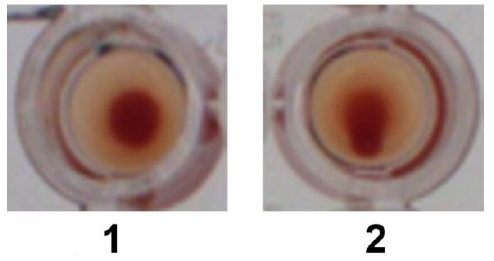
Figure 1. Sample images of wells in which HA occurred (1; no teardrop visible) and HA did not occur (2; teardrop visible).